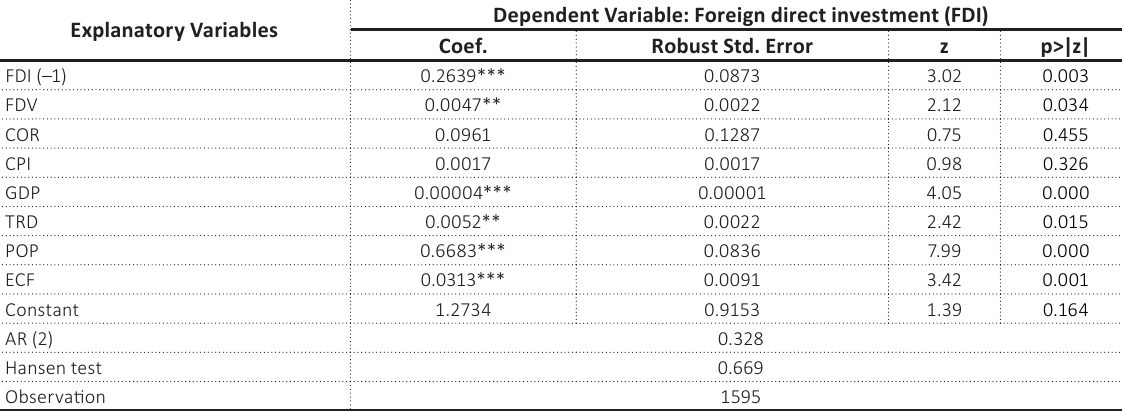
Dependent Variable: Foreign direct investment (FDI)